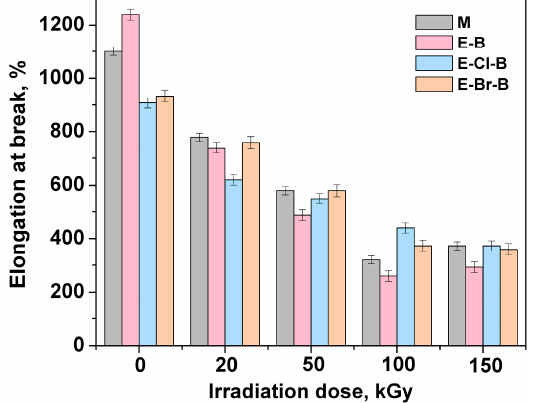
Figure 5. Tensile strength of EPDM/butyl rubber composites as a function of irradiation dose. Polymers 2018 , 10 , x FOR PEER REVIEW 7 of 21